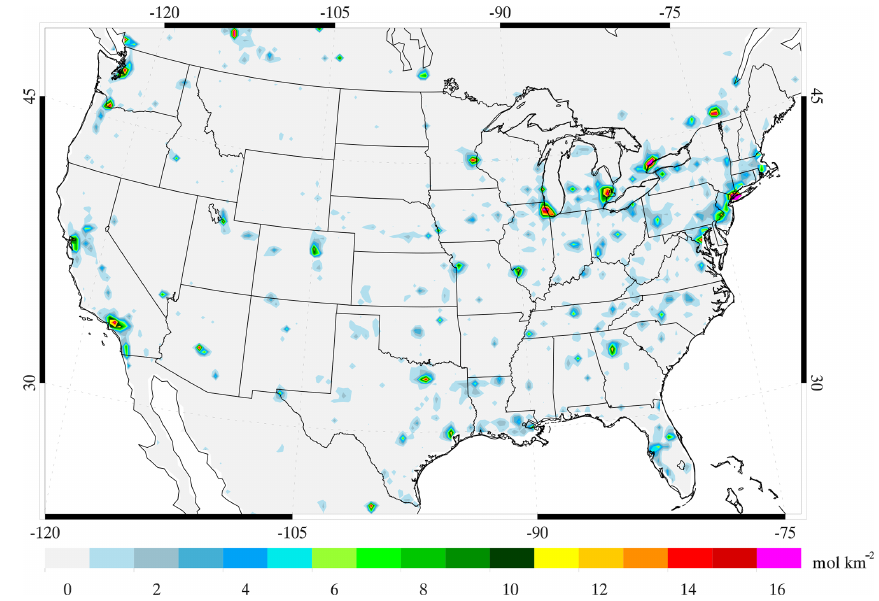
Figure 2. Averaged daily NO x emissions between 2010 and 2015 in the modeling domain (in moles per square kilometer).